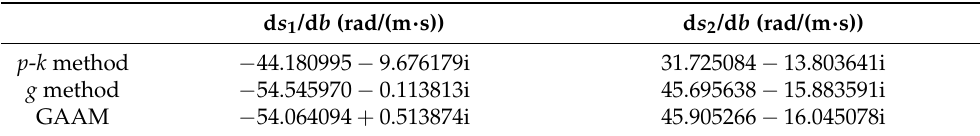
Figure 3. Eigenvalue solutions for the typical section model employing the p - k method, the g method and GAAM at V = 209.6 m/s for changing half chord length b displayed in the complex plane. The eigenvalue derivatives scaled by ∆ b max are depicted as tangent lines at the unchanged eigenvalue solution (center × ). Table 2. Eigenvalue derivatives with respect to the half chord length b for the typical section model employing the p - k method, the g method and GAAM at V = 209.6